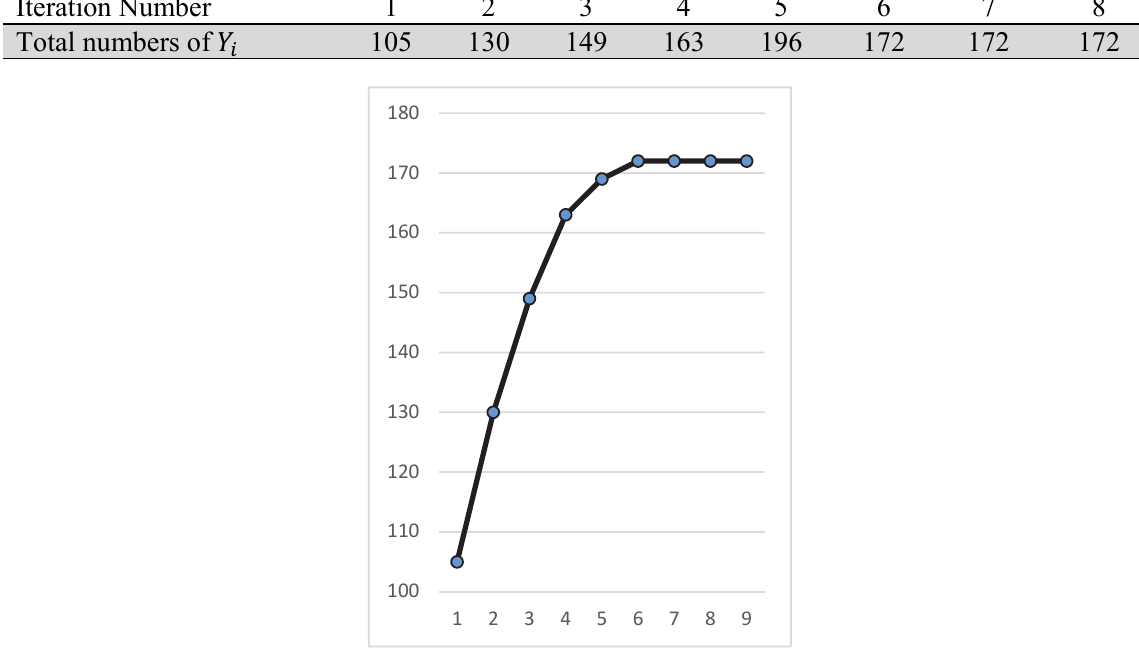
in each iteration (cid:2919)